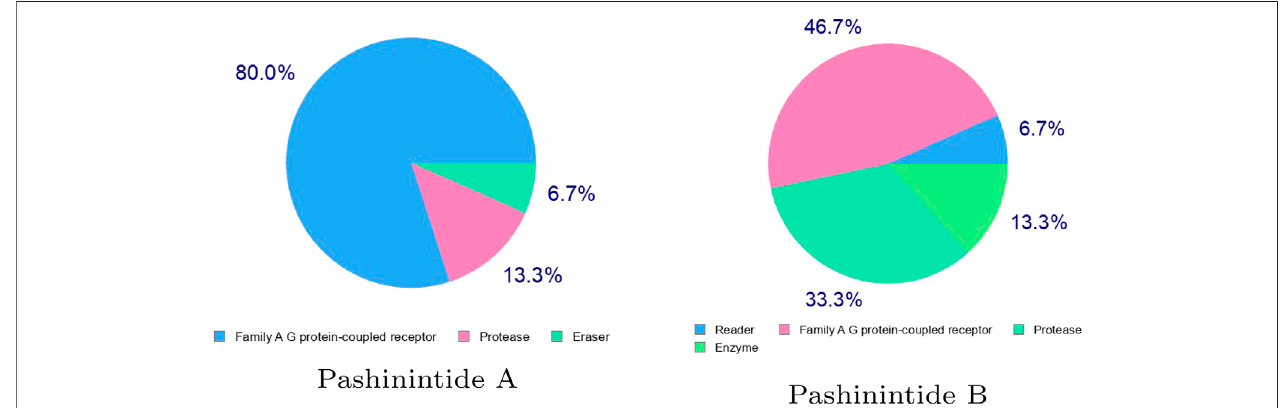
FIGURE 3 | Predicted biological targets of the Pashinintides A and B.